Question: Write a caption explaining this figure to a reader.
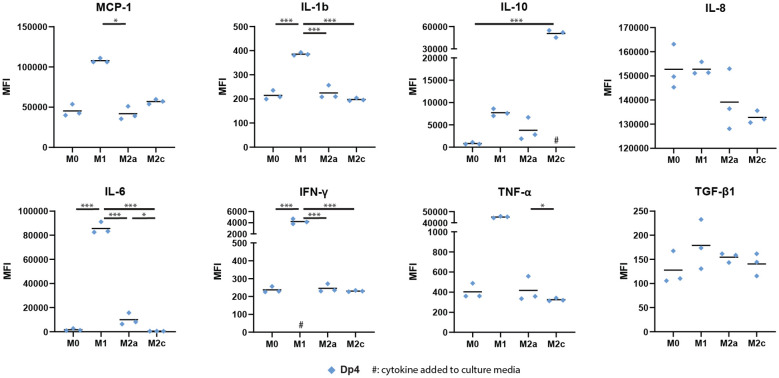
Answer: Protein expression of polarized macrophages. Cytokine/chemokine measurements using the LEGENDplex™ assay on medium from M0, M1, M2a, or M2c polarized macrophages. For each replicate, two wells were pooled into one sample, with three samples (i.e. n=3 replicates) for donor pool 4 (Dp4). Mean fluorescence intensity (MFI) shown with line as mean. # denotes samples where the specific cytokine was present in the polarization media. * p < 0.05, *** p < 0.001.